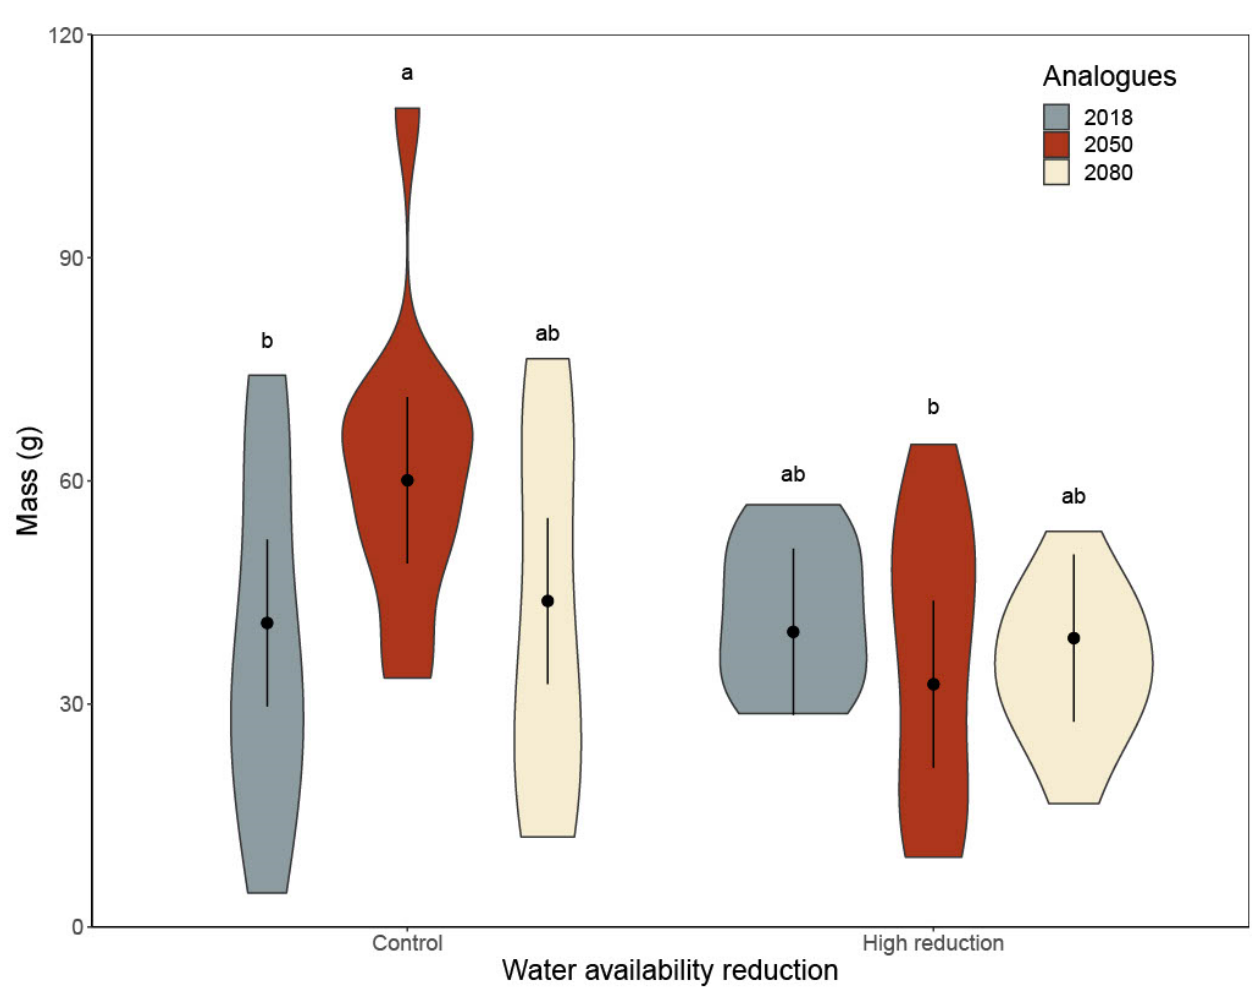
Figure A3. Differential effect of water availability on northern red oak ( Quercus rubra L.) mass among climate analogues. Seedling dry mass ( 𝑥̅ ± 95%CI of model estimates) was measured after ten weeks of growth in a greenhouse under two levels of water availability (control: 80% of pot capacity; high reduction: 25%). Three different climate analogues were used (2018: analogue to the current climate at Réserve faunique de Portneuf (Québec, QC, Canada); 2050: analogue to the climate predicted for mid-century; 2080: analogue to the climate predicted for the end of the century). The analysis was performed using a linear mixed model with a random effect of blocks ( n = 5). To account for differences between the initial mass of seedlings, height at the beginning of the experiment and its interactions were included as a covariate in the model. Different letters indicate a posteriori least square mean differences performed on climate analogue and water availability treatment ( α = 0.05). Shapes represent the distribution of the data